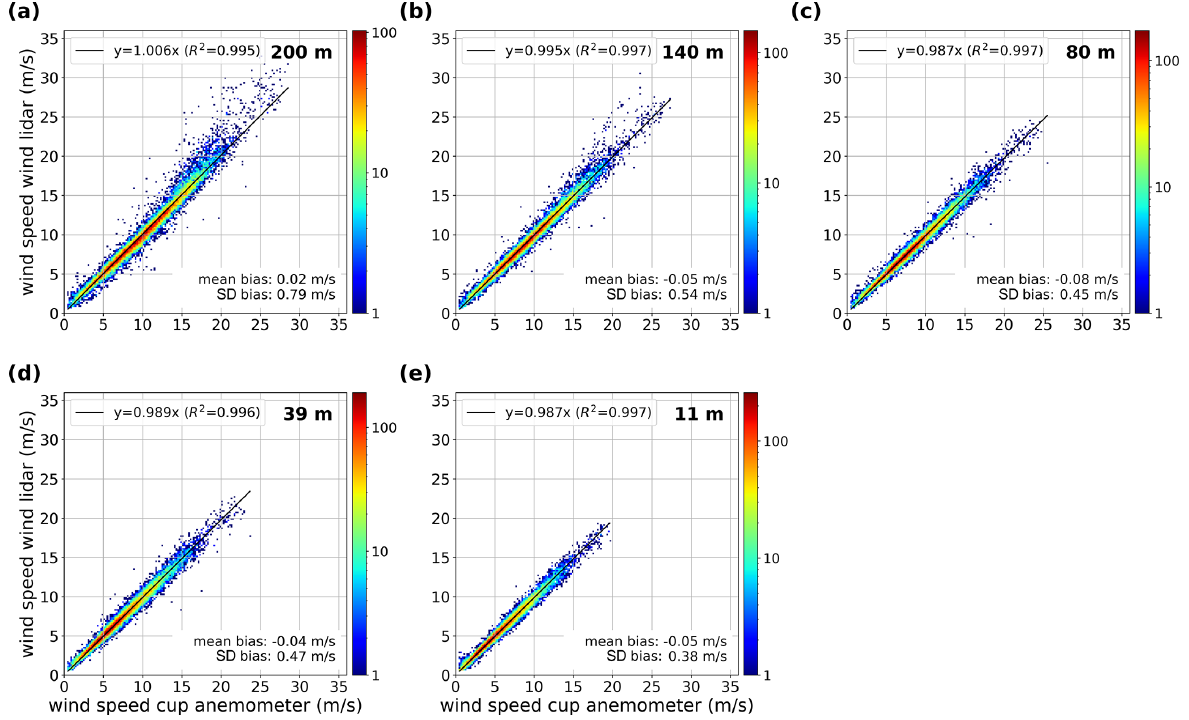
Figure 7. Wind speed comparison between wind lidar and mast data for the different heights: (a) 200m, (b) 140m, (c) 80m, (d) 39m and (e) 11m. The results of a linear regression analysis and the mean bias and standard deviation in the bias are indicated in each panel.